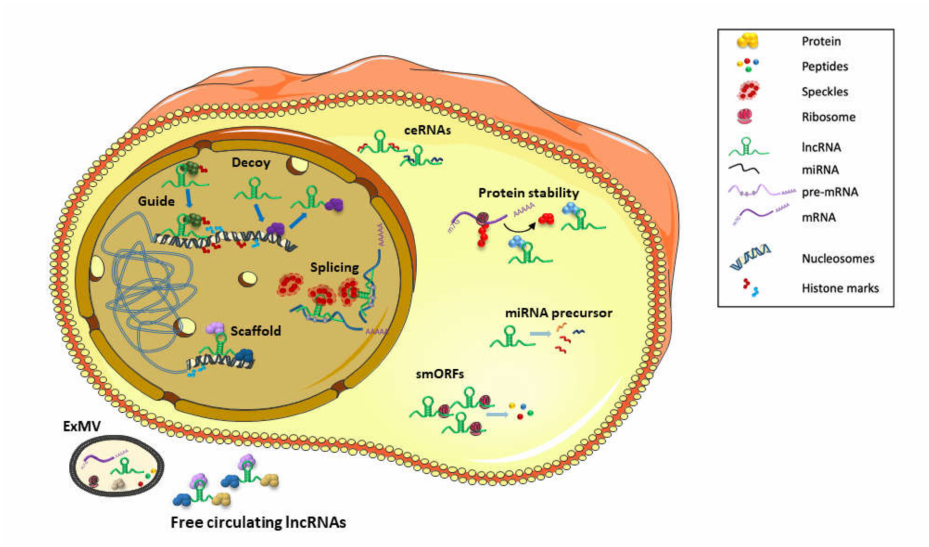
Figure 1. LncRNAs functions in HBV-related HCCs. The nuclear or cytoplasmic localization of lncRNAs reflects their mode of action. Nuclear lncRNAs are involved in nuclear organization, chromatin function by sequestering (decoy), guiding toward their target loci (guide) or tethering (scaffold) transcription factors or chromatin-modifying complexes and RNA maturation (splicing). In the cytoplasm, lncRNAs are involved in post-transcriptional mechanisms of gene regulation by: (a) binding to complementary sequences on miRNAs and relieving the repression of targeted mRNAs (Competing Endogenous RNA or ceRNAs); (b) binding to cytoplasmic proteins and affecting their stability; (c) acting as precursors of miRNAs; and (d) coding for small peptides through small open reading frames (smORFs). Circulating lncRNAs in extracellular fluids are found complexed to proteins (free circulating lncRNAs) or in extracellular microvescicles (exMVs), comprising both exosomes and larger